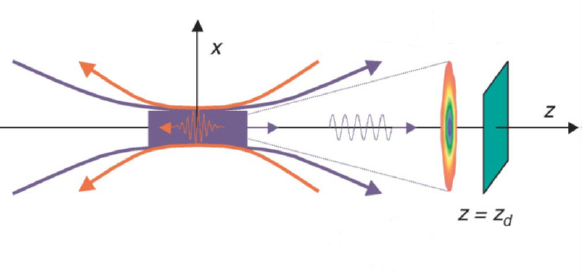
Figure 4. Laser and scattered X-ray beam longitudinal profiles. The screen in green represents the detector and z d is the relevant longitudinal coordinate. (see Ref. [33] for further